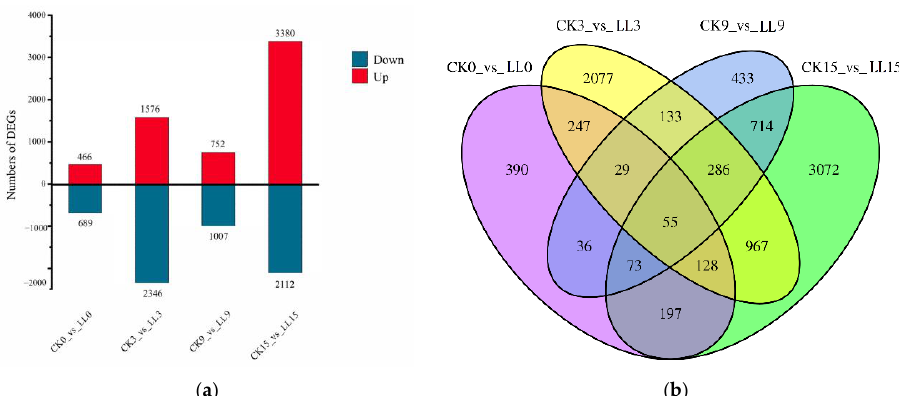
Figure 2. The numbers of up- and down-regulated differentially expressed genes (DEGs) between low light and control under different developments ( a ), Venn diagram of the differentially expressed genes (DEGs) between low light and control ( b ).